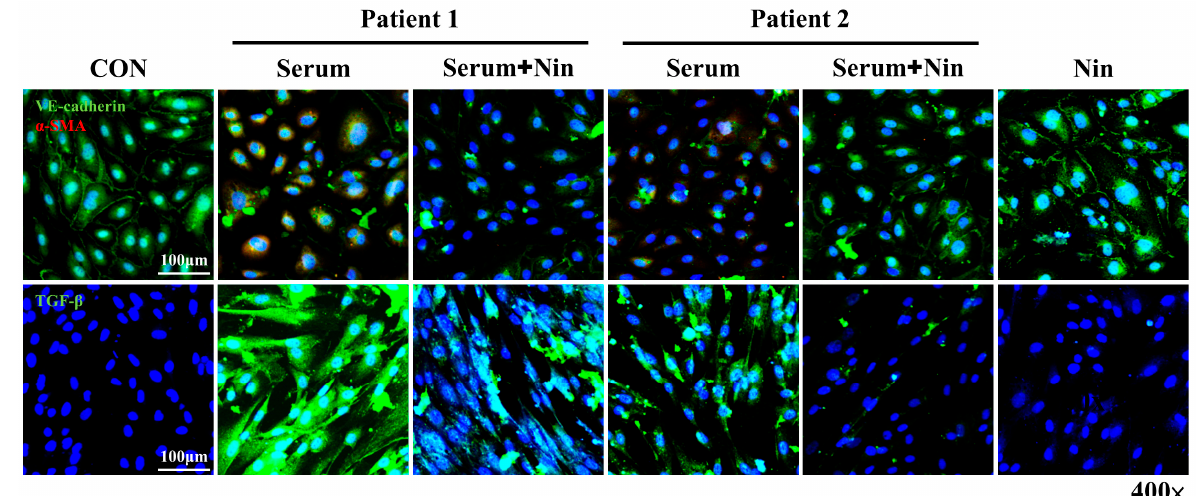
Figure 6. In vitro EndoMT is promoted by IPF but inhibited by nintedanib. Representative IF staining images of VE-cadherin, α -SMA, and TGF- β in HPMECs treated with IPF serum (from patients with IPF) or nintedanib alone or in combination. Scale bars, 100 µm. α -SMA, alpha smooth muscle actin; EndoMT, endothelial mesenchymal transition; HPMEC, human pulmonary microvascular endothelial cell; IPF, idiopathic pulmonary fibrosis; TGF- β , transforming growth factor beta; VE-cadherin, vascular endothelial cadherin. Green, VE-cadherin; red, α -SMA; blue, DAPI.